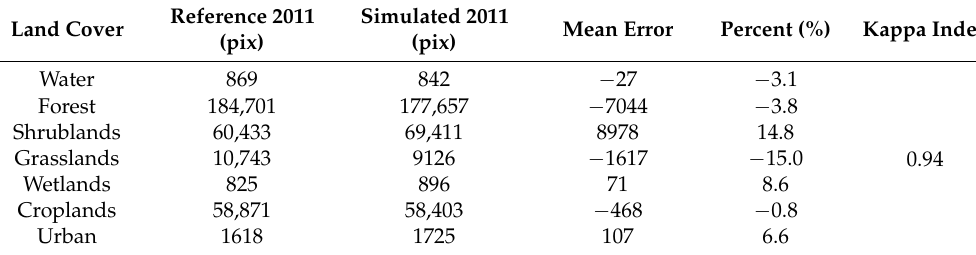
Grasslands 10,743 Wetlands Croplands